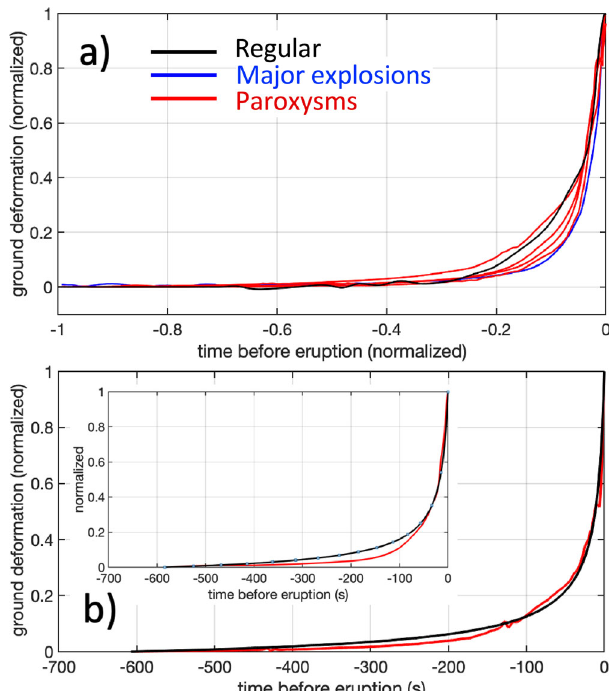
Fig. 4 A Scale-invariant of ground deformation pattern. a Normalized ground tilts of the in fl ation events recorded during the four paroxysms (red) and the stacking of 39 major (blue) and 2000 regular (black) Strombolian explosions. In fl ations (represented as a function of the normalized time before the onset of the eruption) show a very similar exponential deformation trend with a best- fi t ranging between 0.89 and 0.99. These high best- fi t values suggest that in spite of the different amounts of energy involved (Fig. 3), the explosive process is controlled by the same conduit dynamics. b The exponential trend of the in fl ation remarkably resembles the expansion of the gas in magma by magmastatic decompression (black line). In the case of the 3-July paroxysm (red line), the best fi t (0.99) is reached using Eq. (2) for the 610 s long expansion of a vesiculated magma with a high volumetric expansion ratio of V/Vo = 15.9. In the inset, the expansion model calculated for the 28 August paroxysm shows a best fi t of 0.98 for a volumetric expansion ratio of V/Vo = 12 and an expansion duration of 590 s.